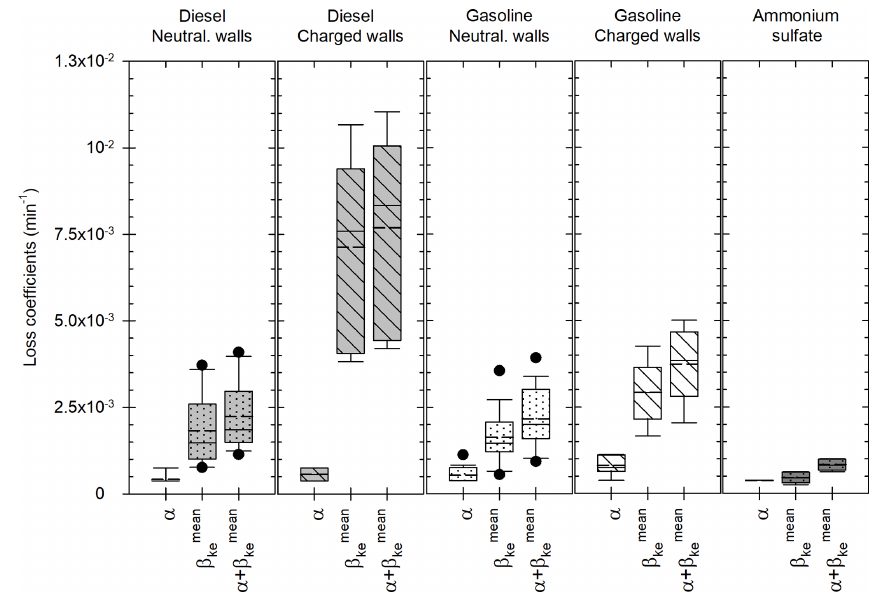
Figure 4. Leakage coefficient α , wall loss coefficient β mean (accounting for channel size) and total loss coefficient α + β mean for the chamber k e k e experiments performed with particles from diesel (light grey) and gasoline (white) engines, as well as ammonium sulfate particles (dark grey). Coefficients for the diesel and gasoline experiments are sorted into two categories: “neutralized wall” experiments for which [BC] evolution follows a first-order exponential decay (dotted boxplots) or “charged wall” experiments for which [BC] evolution follows a second-order exponential decay (hatched boxplots). The boxes represent the 25th and 75th percentiles. The solid line in the center represents the median; the dashed line represents the mean. The whiskers are the 10th and 90th